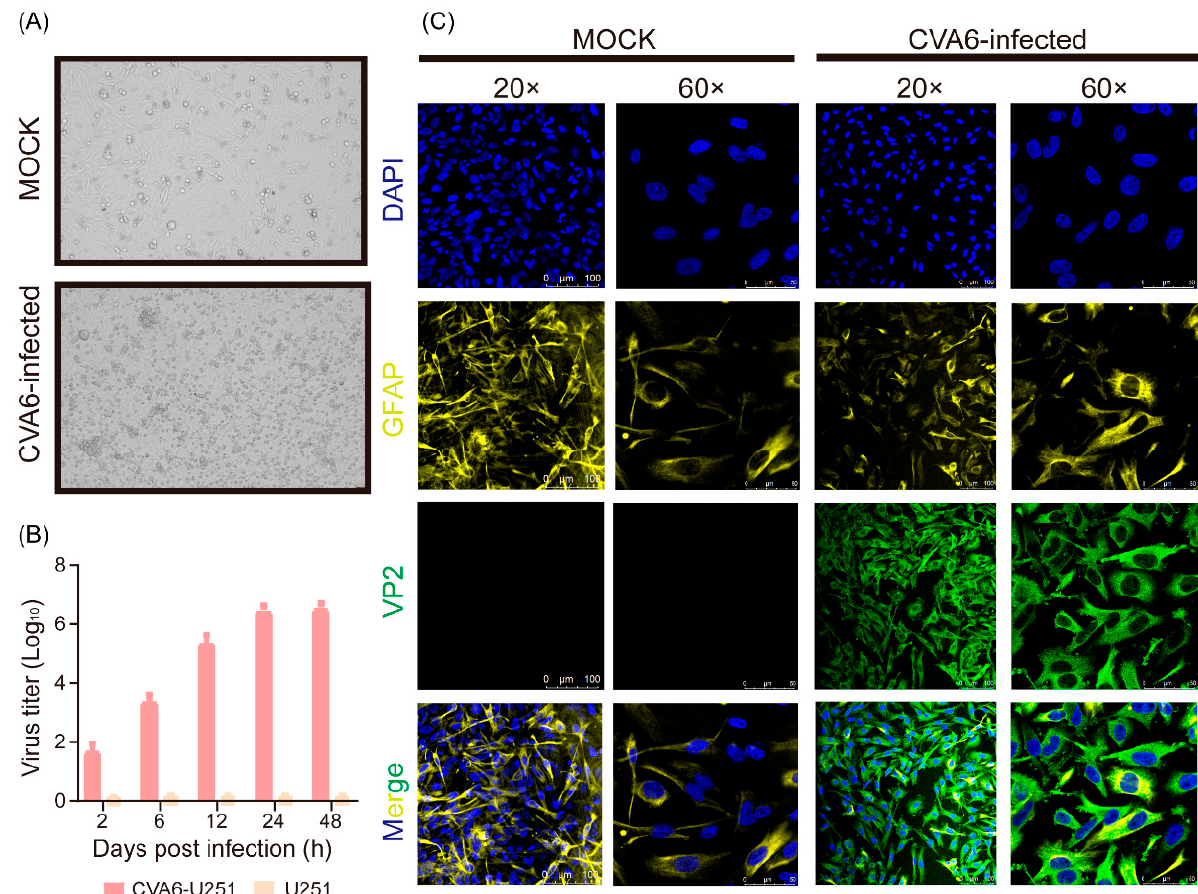
Figure 4. CVA6 infects U251 cells. Cytopathic effect of virus on U251 at 24 h post infection ( A ); cells were inoculated with CVA6 at 37 °C, and harvested at 2, 6, 12, 24, and 48 h post-inoculation. Virus titers were determined on RD cells ( B ); U251 cells infected with CVA6 and control were fixed and immunostained with DAPI (Blue), astrocyte marker (GFAP, Yellow), and VP2 (Green). The representative images were acquired using fluorescence confocal microscopy. Magnifications: ( A , B ), ×200 × 600. Scale bar = 100 µ m ( C ).